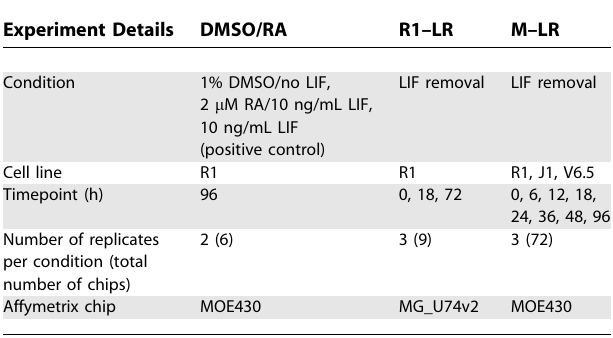
Table 1. Summary of All Microarray Experiments Used in